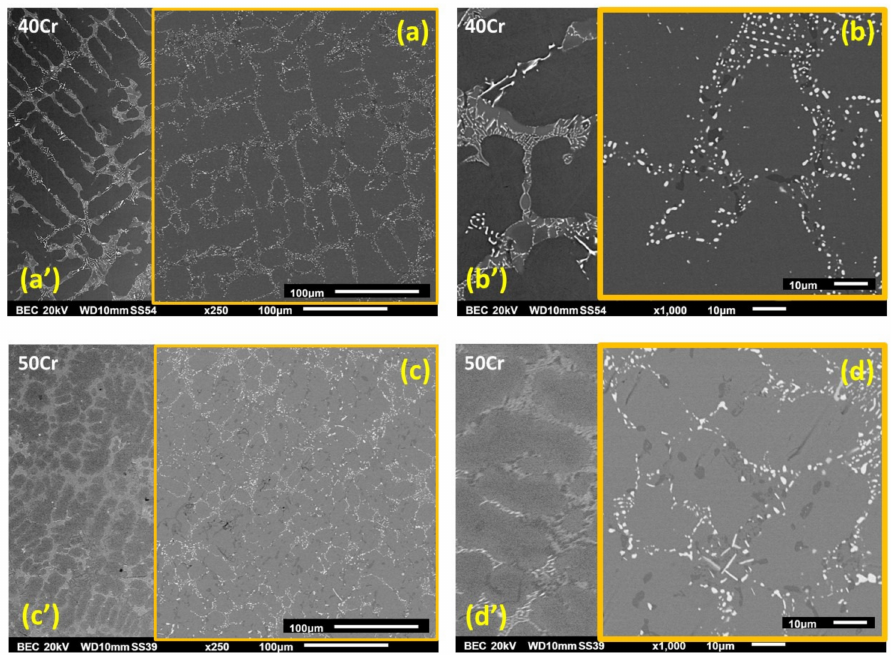
Figure 9. The (1400 K; 96 h)-aged microstructures (framed in orange) of the 40Cr ( a , b ) and 50Cr ( c , d ) alloys; general ( × 250: ( a , c )) and detailed ( × 1000: ( b , d )) views; addition of the as-cast microstruc- tures (40Cr: ( a ’, b ’), 50Cr: ( c ’, d ’)) for